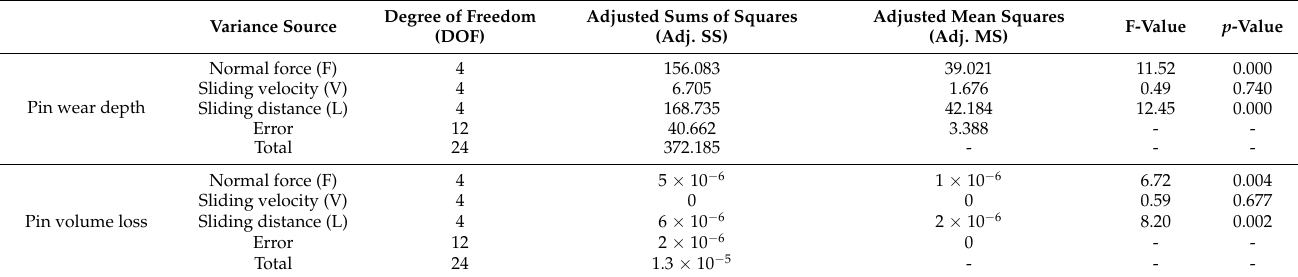
Figure 8. Effect of control factors on the signal-to-noise (S/N) ratio for ( a ) pin wear depth and ( b ) pin volume loss. Table 5. Results of ANOVA for pin wear depth.